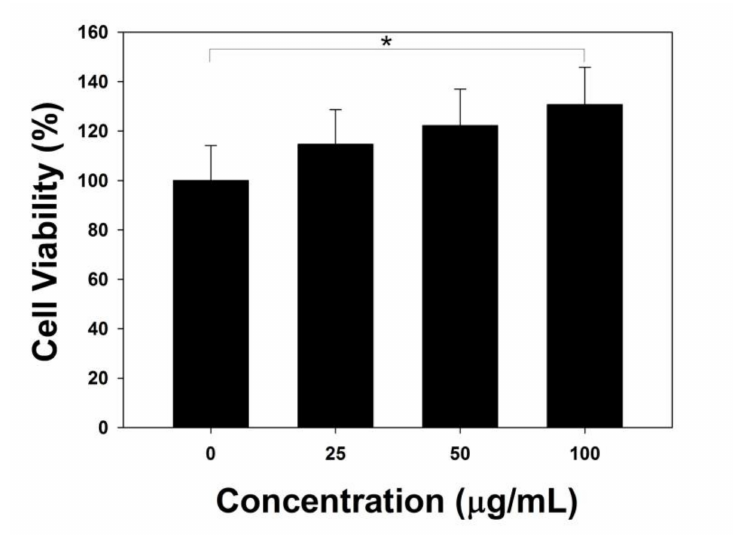
Figure 6. Cytotoxicity test of TA (10 mg) / CaO 2 towards macrophages. The data represent mean ± SD (n = 5). * p < 0.05.